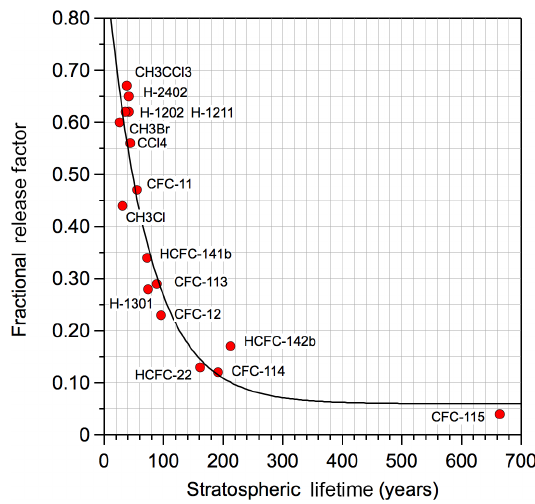
Figure 2. Empirical correlation of fractional release factor (FRF) versus stratospheric lifetime, τ Strat . Stratospheric lifetimes were taken from 2-D model results given in the SPARC (Ko et al., 2013) lifetime report. The FRFs were taken from WMO assessment (WMO, 2014). The solid line is a fit to the data: FRF = 0.06 + 0.875 exp( − 0.01444 × τ Strat )